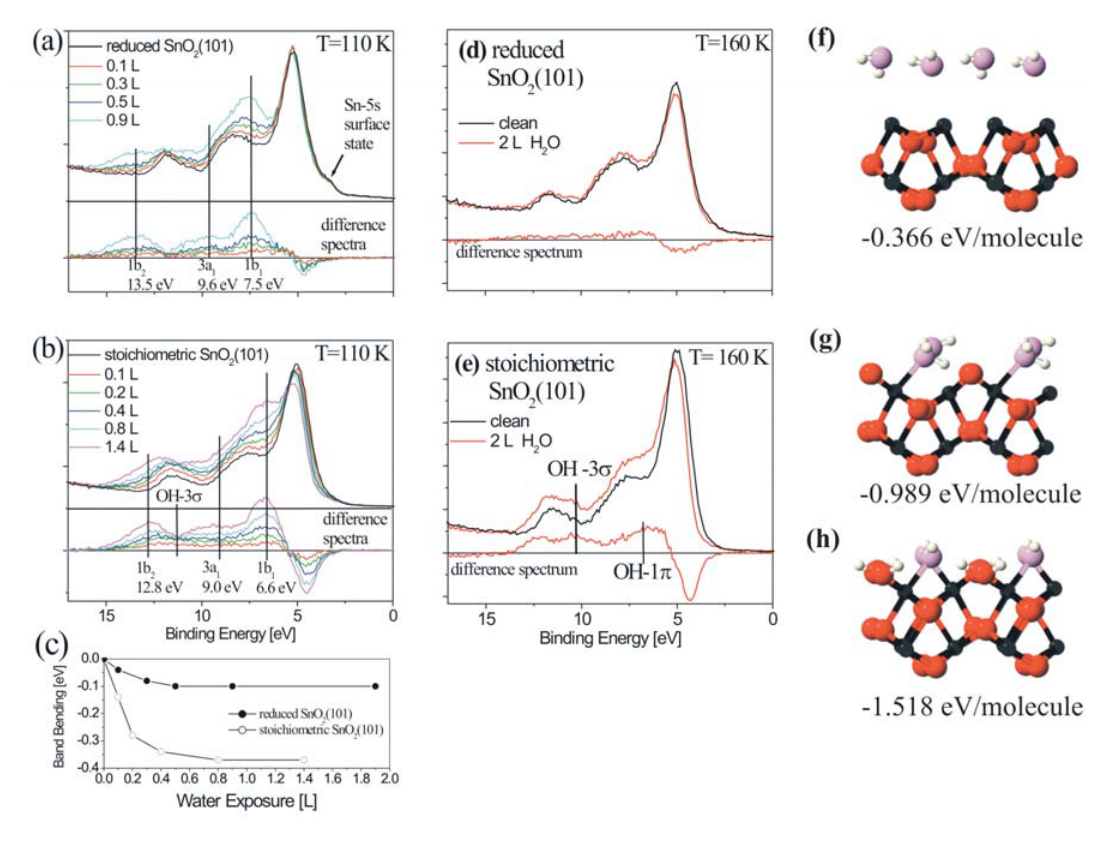
Figure 12 . Water adsorption on the reduced and stoichiometric SnO (101) surface studied by UPS 2 measurements and DFT calculations. Adsorption at 110 K is shown in (a)-(c) for the reduced surface (a) and stoichiometric surface (b). Band bending effects upon water exposure is plotted in (c) for the two surfaces. UPS measurements for water exposure at 160 K is shown in (d) for the reduced surface and in (e) for the stoichiometric surface. Only on the stoichiometric surface (e) adsorption and dissociation of water is observed at 160 K. Models of water adsorption derived from DFT calculations are shown in (f) for the reduced surface and (g) and (h) for the stoichiomteric surface for molecular and dissociative water adsorption, respectively. Calculated adsorption energies are also